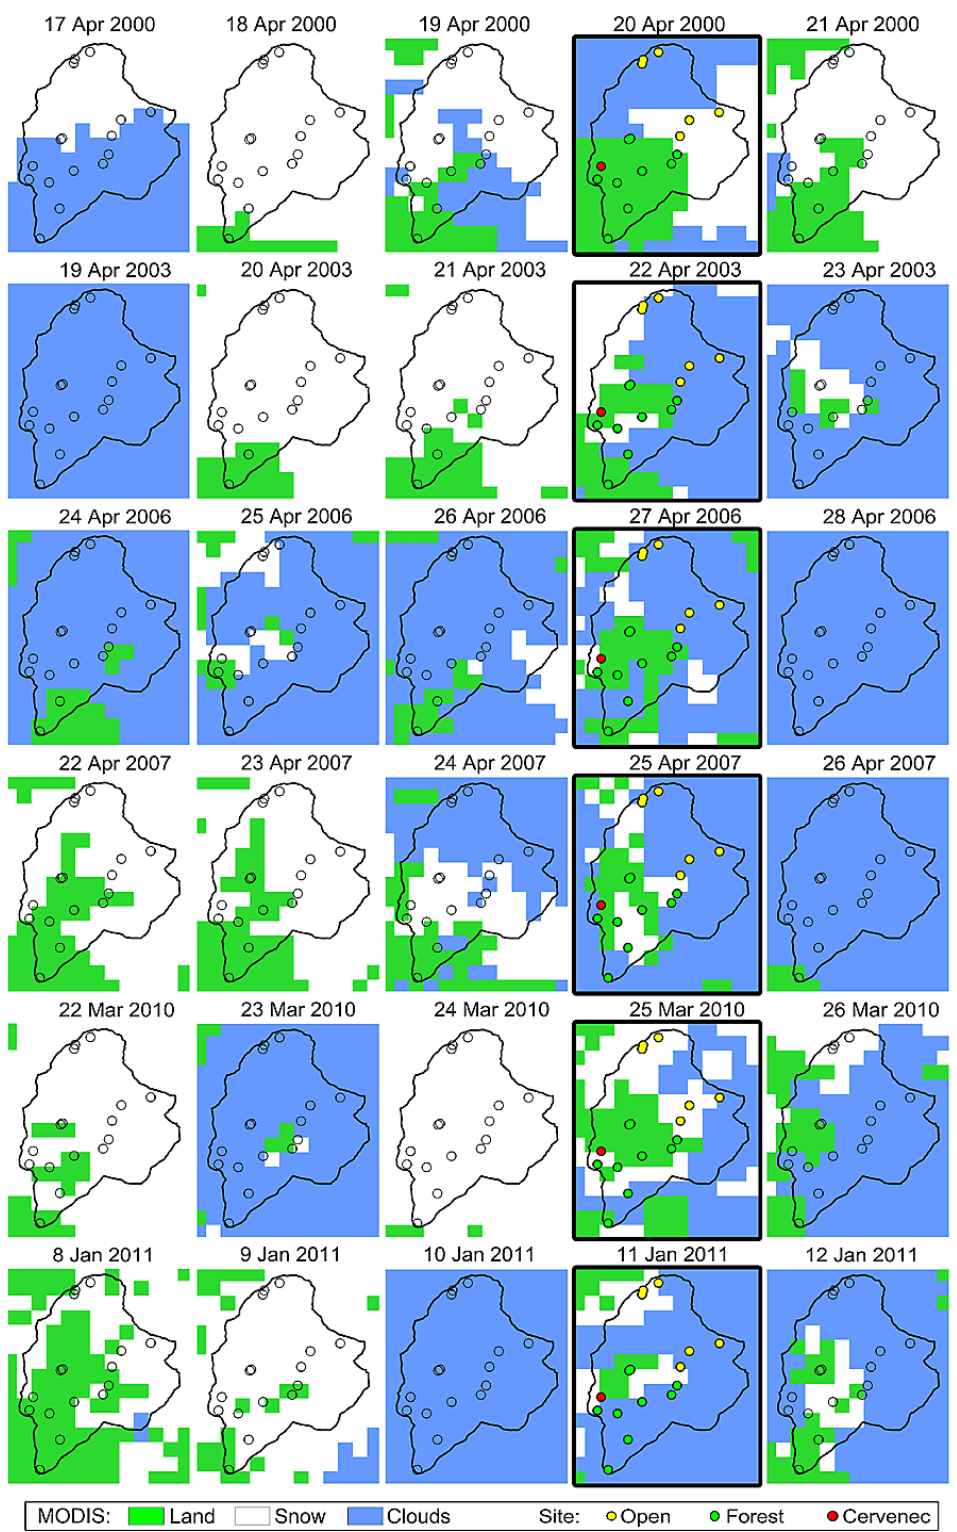
Fig. 9. Misclassification of snow as land by the combined MODIS product and 2-day filter of the combined product at ˇCervenec station (Fig. 8). The maps in black frames show the date of ground snow measurement; red circles indicate the site ˇCervenec where misclassification